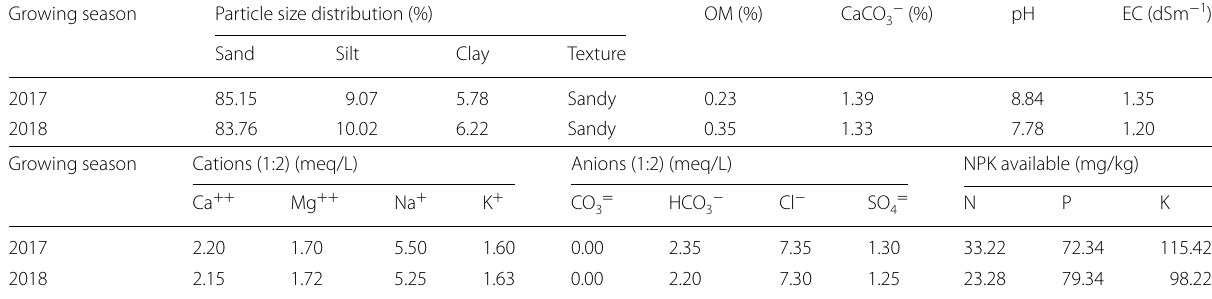
Table 1 Physico-chemical properties of the preferred experimental site during the two seasons Growing season